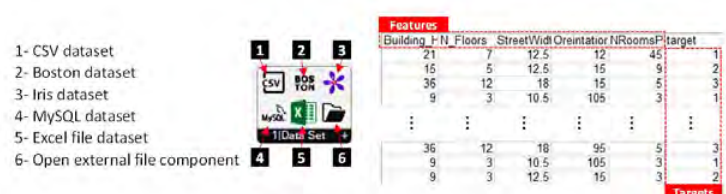
Figure 3. a. Data sets’ components b. The structure of input data